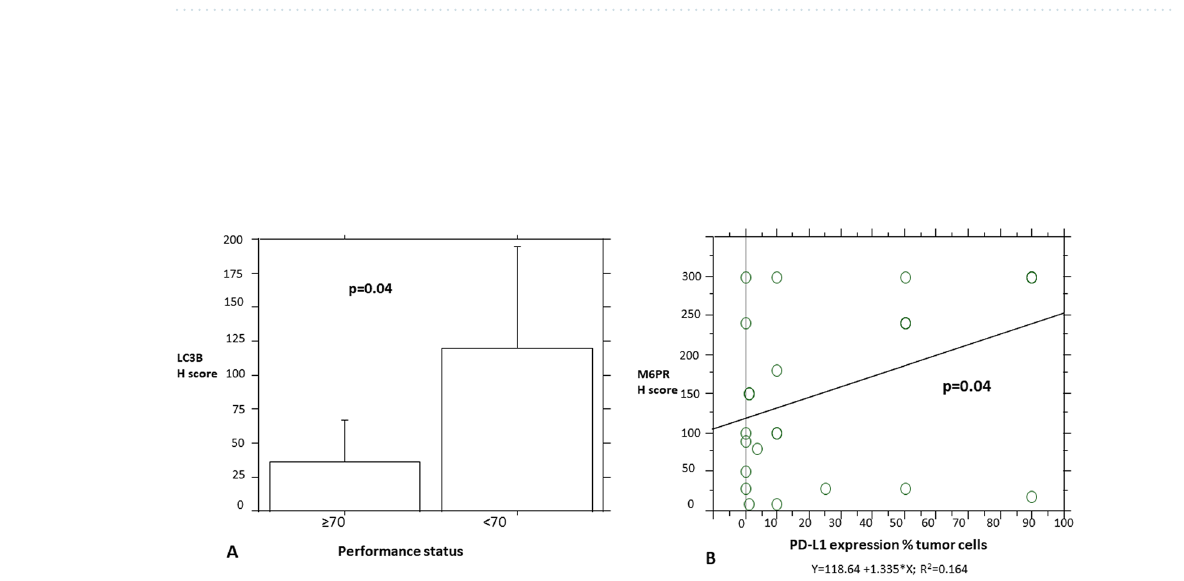
Figure 8. ( A ) The difference in LC3B H score between the two performance status groups. ( B ) Simple regression analysis comparing PD-L1 and M6PR